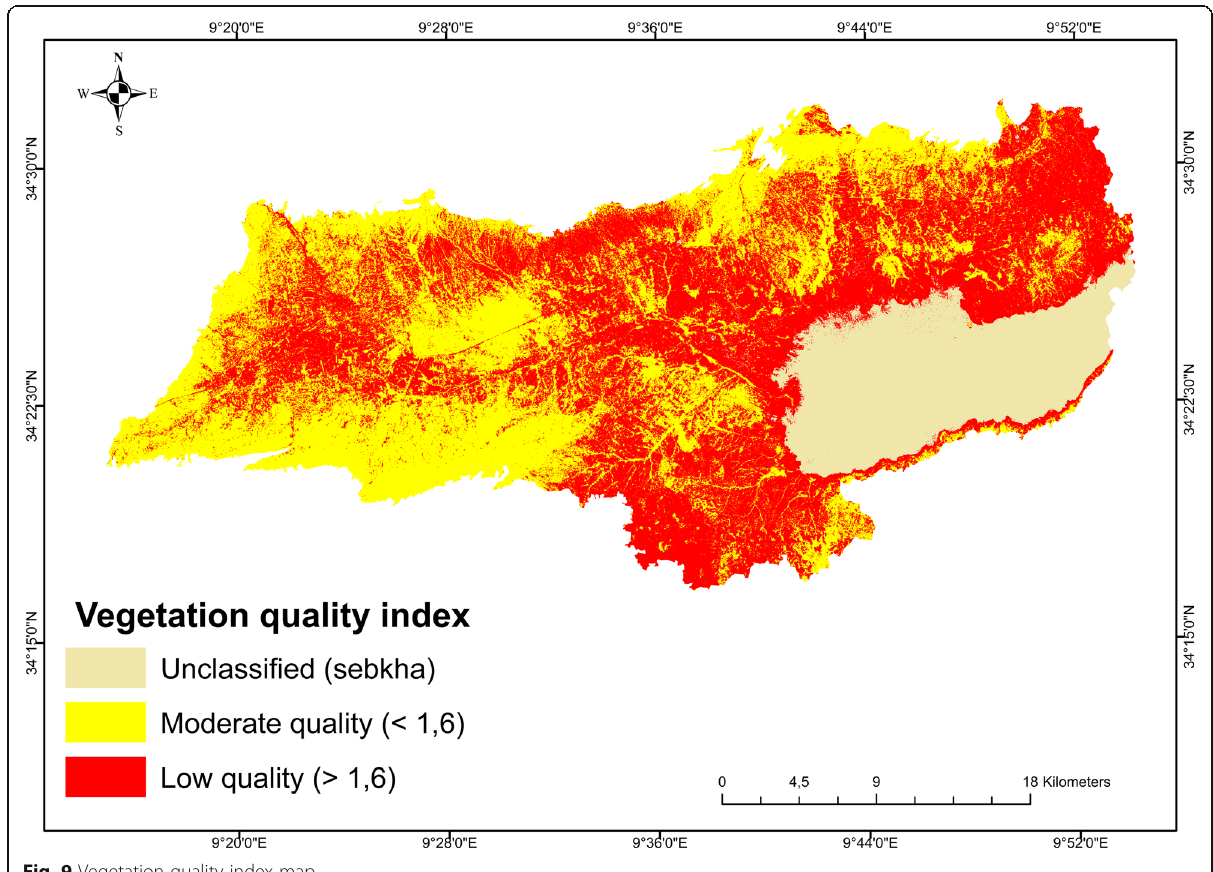
Fig. 9 Vegetation quality index map